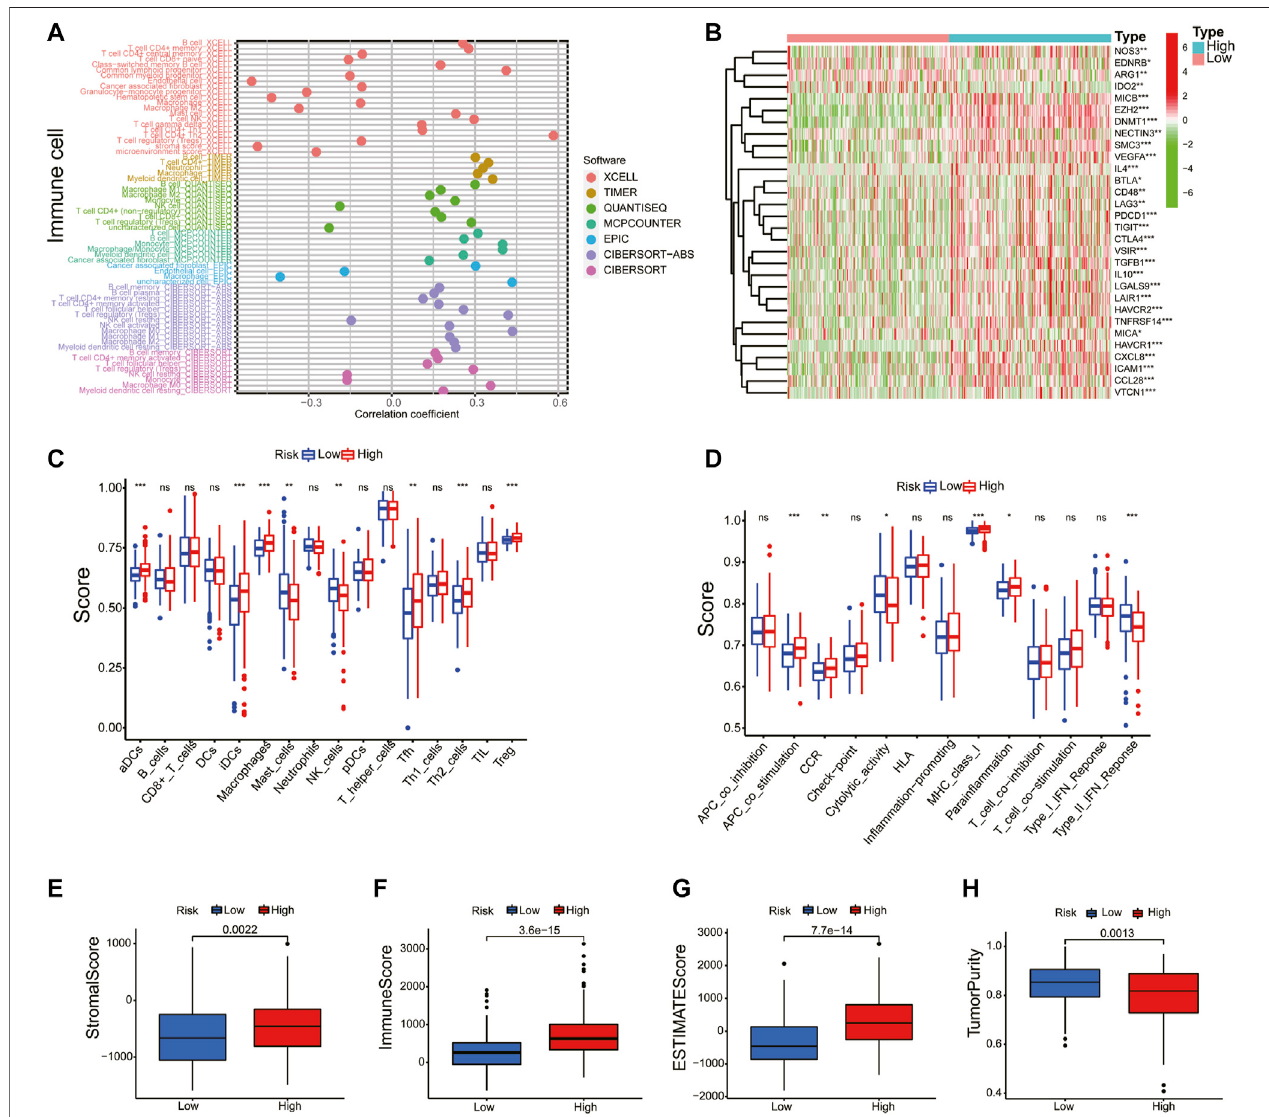
FIGURE 8 | Correlation of immune cell in fi ltration and tumor mutational burden with prognostic signature. (A) A detailed Spearman correlation analysis was also performed using different algorithms. (B) The heatmap revealed the immune-related genes between the high- and low-risk groups. The activity differences of immune cells (C) and immune function (D) between the high- and low-risk groups. The immune score (E) , stromal score (F) , ESTIMATE score (G) , and tumor purity (H) were compared in the high- and low-risk groups.